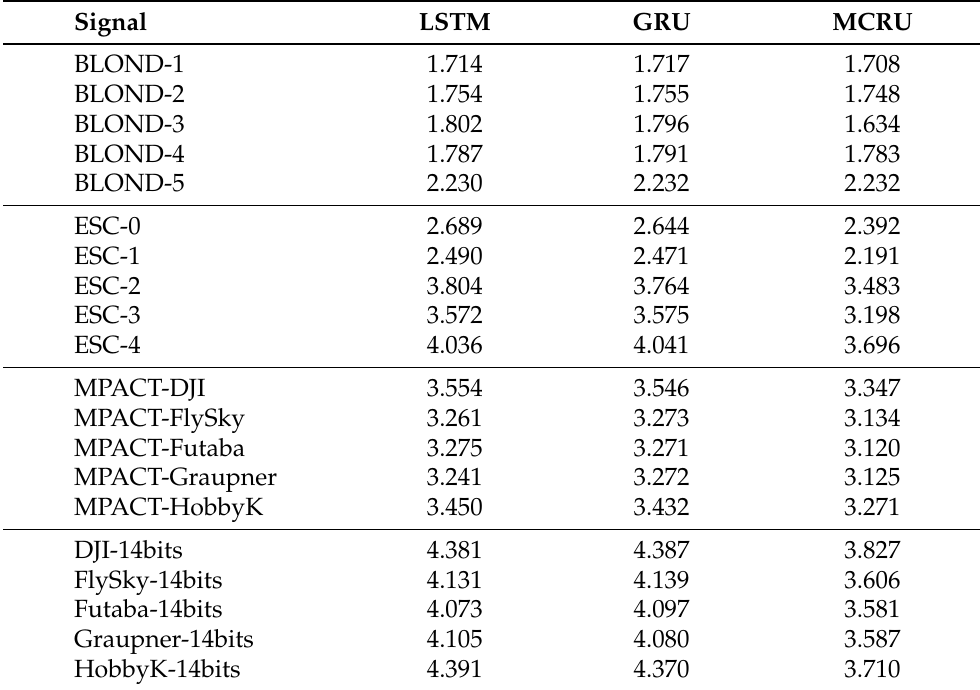
Table 5. The median BPC over 10 runs for each recurrent unit on each